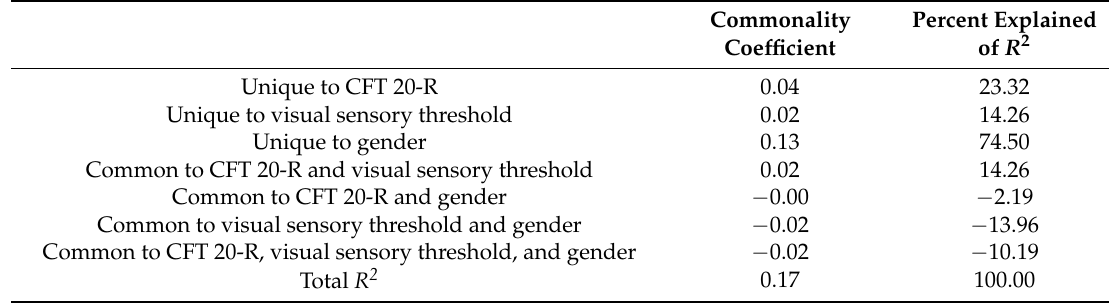
Table 4. Unique and common effects of intelligence and visual sensory threshold in predicting GERT-S